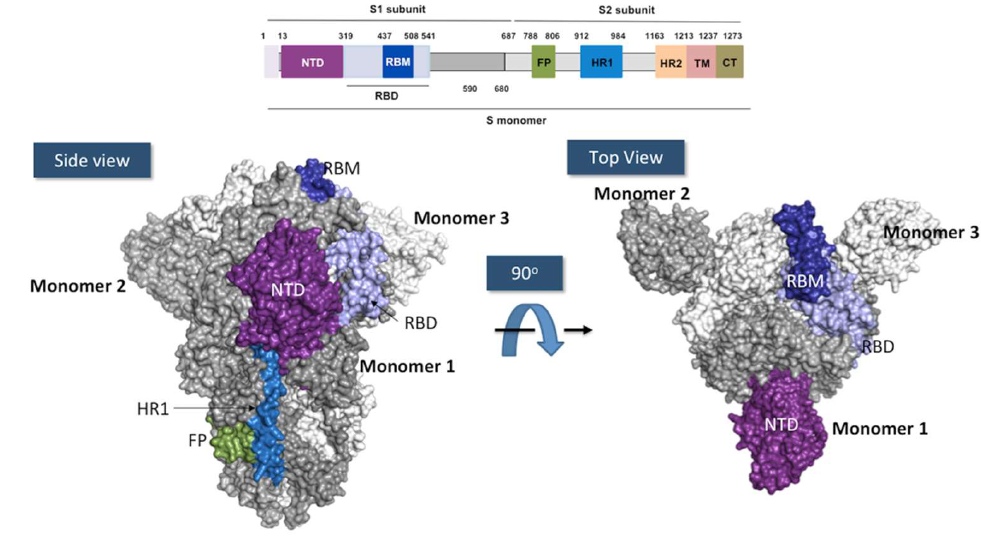
Figure 3. Anatomy of the SARS-CoV-2 spike protein. Above: Schematic representation of the different domains in the subunit 1 and 2 of the SARS-CoV-2 spike. NTD, N-terminal domain (in purple); RBD, receptor binding domain (in light blue); RBM, receptor binding motif (in deep blue); FP, fusion peptide (in forest green); HR1, heptapeptide repeat sequence 1 (in blue); HR2, heptad repeat sequence 2 (in melon orange); TM, transmembrane domain (in pink); CT, cytoplasmic tail (in gold). Below: Two views related by 90° rotation of the surface of Spike homotrimer protein of SARS-CoV-2 in down conformation. Each monomer is colored in white, gray and colors.. The figures were prepared using PyMOL Molecular Graphics System version 2.4.1. Schrödinger, LLC, New York (https://pymol.org/2) using the coordinates of the PDB ID: 7BNM.